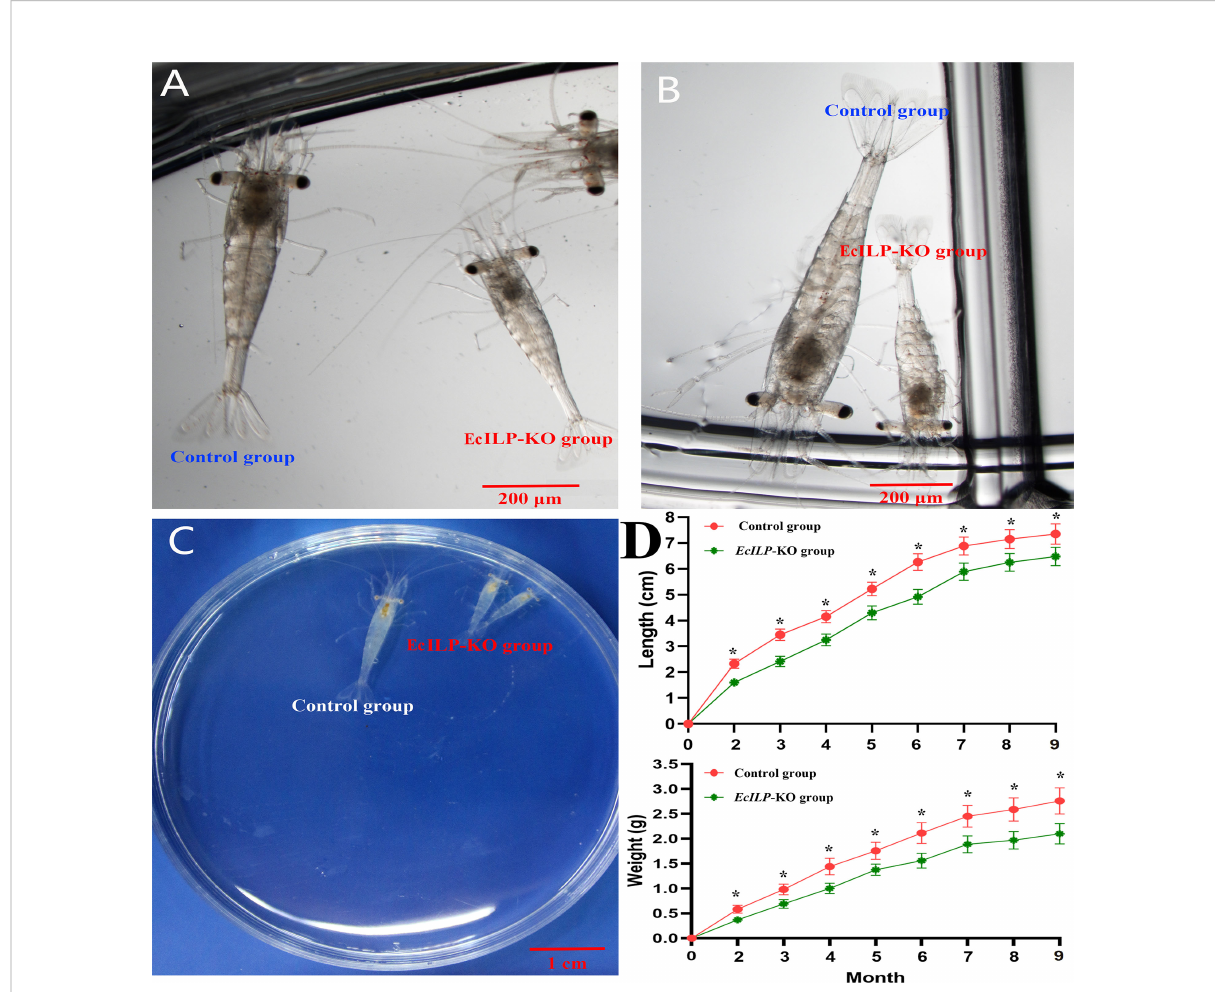
FIGURE 7 Growth comparison of EcILP -KO and control group individuals. (A) 18 days after hatching, (B) 22 days after hatching, (C) One month after hatching, (D) Statistical changes in body length and body weight from 2 to 9 months after hatching. Error bars refer to the standard deviation. P values are denoted: * P <